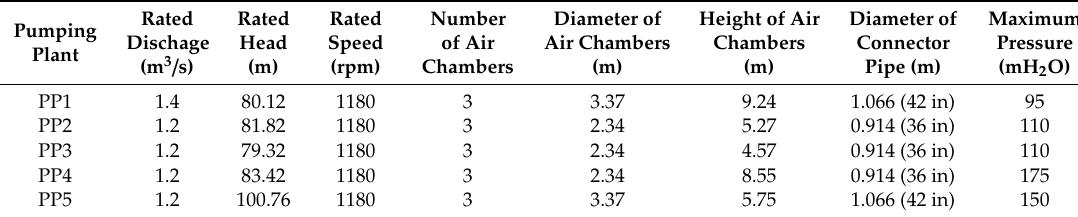
Table 3. Characteristics of the pumps and the air